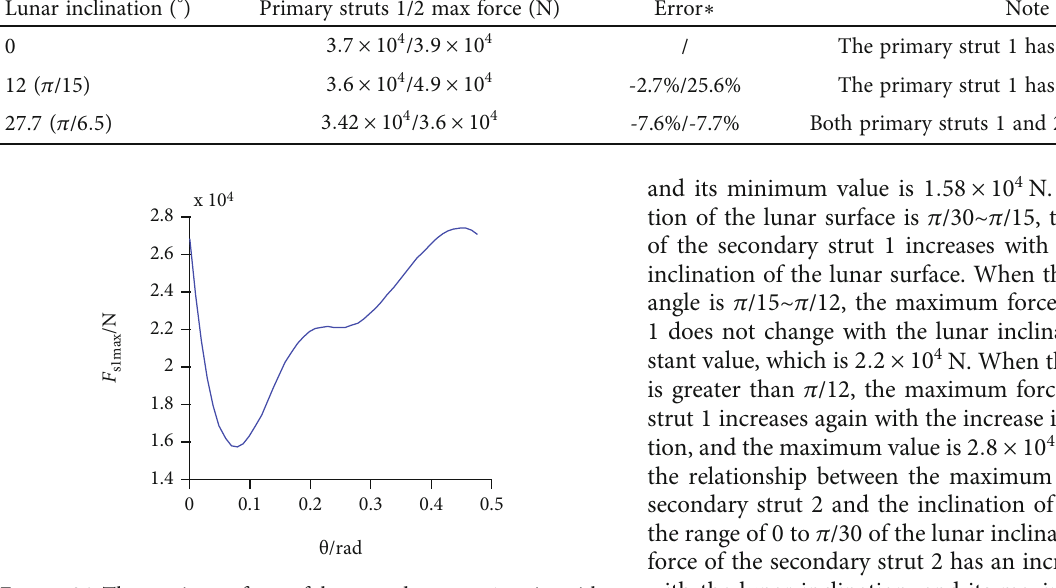
Figure 24: The maximum force of the secondary strut 1 varies with the lunar inclination.